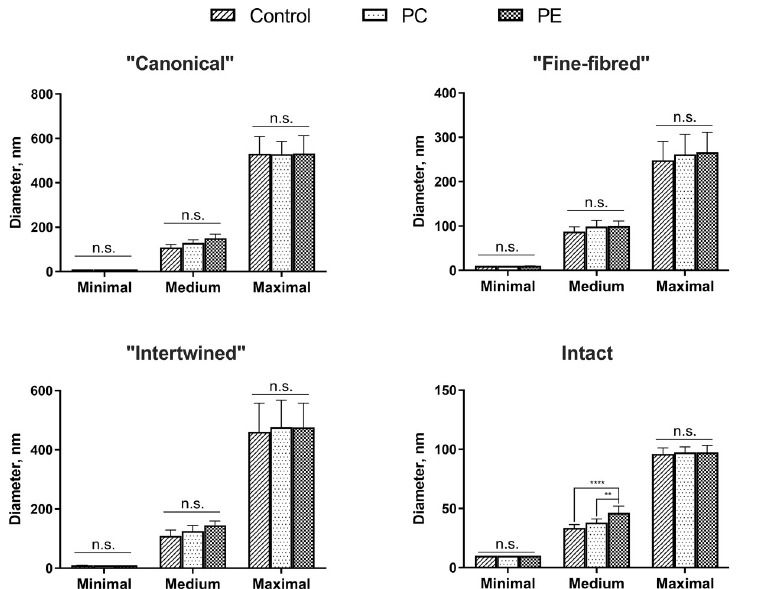
Fig 12. Diameters of collagen fibrils in the studied groups. Statistical significance: �� —p � 0.01, ���� —p � 0.0001, n.s.–non-significant. Two-way ANOVA followed by the Tukey’s test, mean values ± 95% confidence intervals.